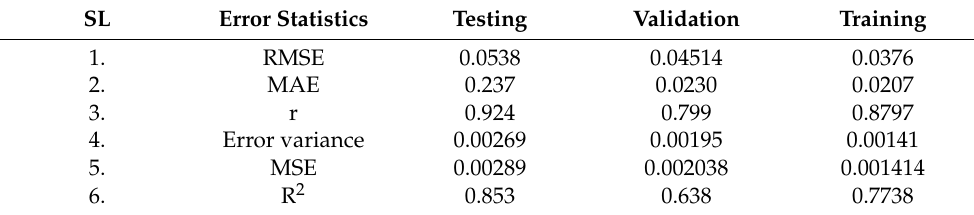
Table 5. Error statistics of ANN model at Polavaram, Godavari River Basin.